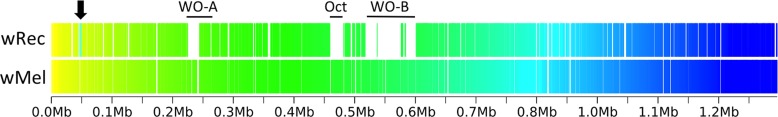
Within-scaffold wRec synteny compared to wMel.wRec scaffolds were concatenated in the order in which they appear in wMel and within-scaffold synteny was analyzed. Genes are graphed as tick marks colored on a gradient from yellow to blue from left to right with wMel as the reference genome and each wRec gene colored according to the location of its homolog in the wMel genome. White spaces in wRec alone indicate the absence of homologous genes or genes with multiple paralogs whose synteny cannot be established, while white spaces shared by both genomes indicate intergenic regions. A 5 kb region of rearrangement consisting of repetitive elements and hypothetical proteins is noted with an arrow, and phage-related regions are marked.